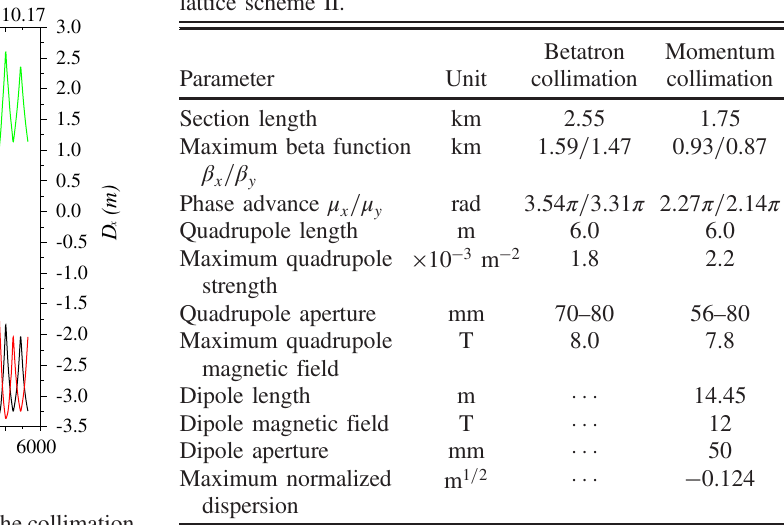
FIG. 3. The betatron and dispersive functions in the collimation insertion in lattice scheme II.